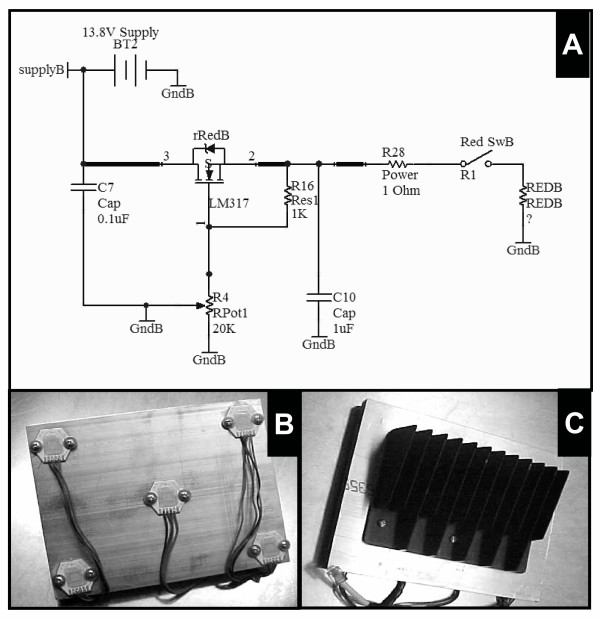
A) The schematic of the Tunable LED controller circuit used in Design 1. The controller regulates the output of four sets of five LEDs. The schematic represents the circuit used to power one color (R, G, or B) in five separate HEX chips, and therefore is repeated twelve times in the controller unit in this arrangement. The 5 HEX LED bank is shown from a bottom (B) and top (C) view.